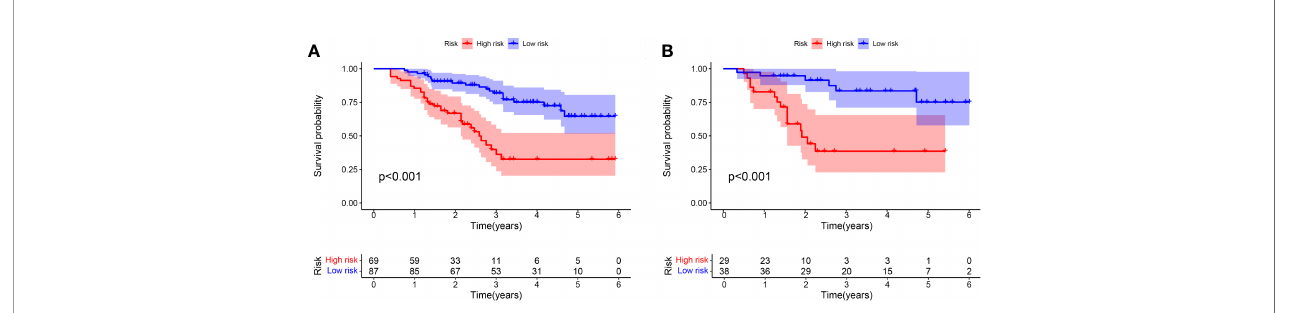
FIGURE 2 | There are signi fi cant differences between patients in HPSS risk groups. (A) High-risk patients in the training set had signi fi cantly lower overall survival than low-risk patients; (B) High-risk patients in the validation set had signi fi cantly lower overall survival than low-risk patients.